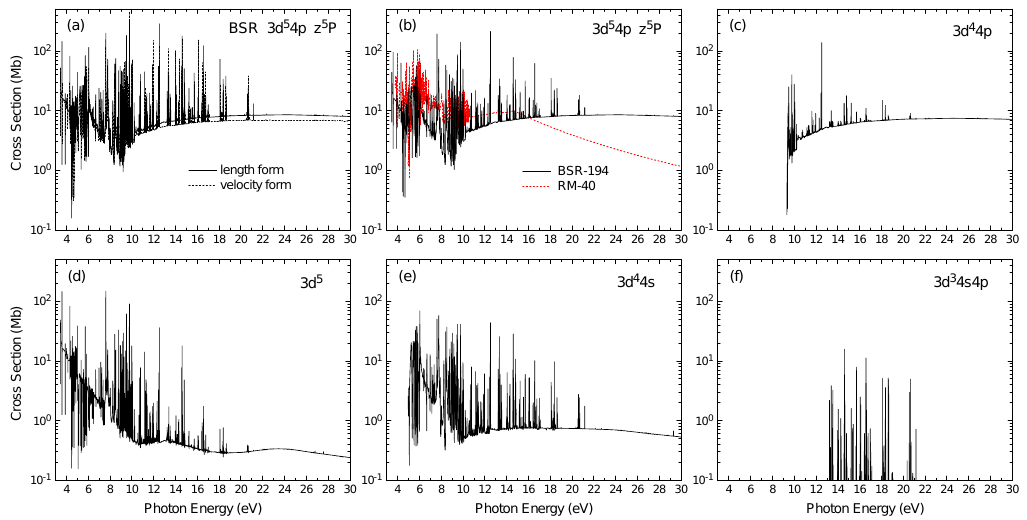
Figure 4. Total and partial photoionization cross sections from the excited 3 d 5 4 p z 5 P state of Cr I as a function of photon energy. Panel ( a ) shows total cross sections from the present BSR-194 model in the length and velocity forms. Panel ( b ) compares the BSR-194 model with the RM-40 calculations of Nahar [14]. Panels ( c – f ) show summed partial cross sections for leaving the residual Cr II ion in final states of the 3 d 5 , 3 d 4 4 s , 3 d 4 4 p , and 3 d 3 4 s 4 p configurations,